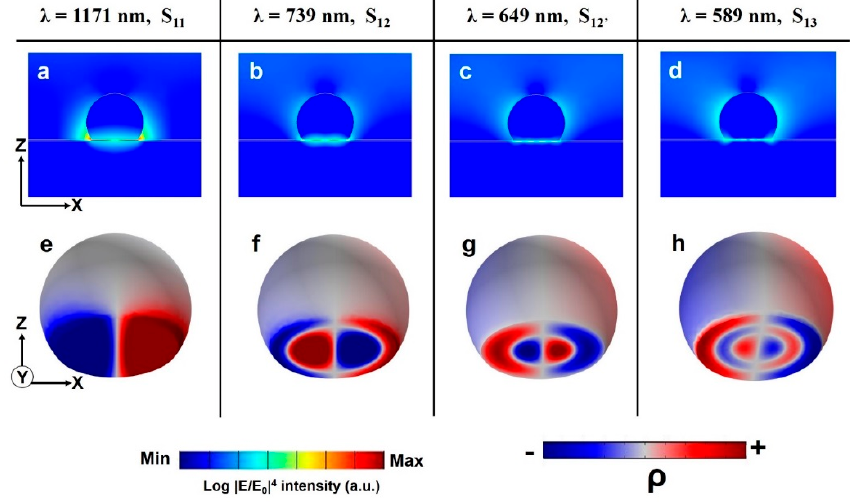
Figure 3. Electric field amplitude and 3D surface charge distribution profiles taken from NPOM plasmonic structure with sphere “ D ” 80% for S 11 ( λ = 1171 nm), S 12 ( λ = 739 nm), S 12 ′ ( λ = 649 nm) and S 13 ( λ = 589 nm) modes. Cross-sectional XZ ( a – d ) electric field amplitude profiles and related 3D surface charge distributions from NP standalone view ( e – h ).